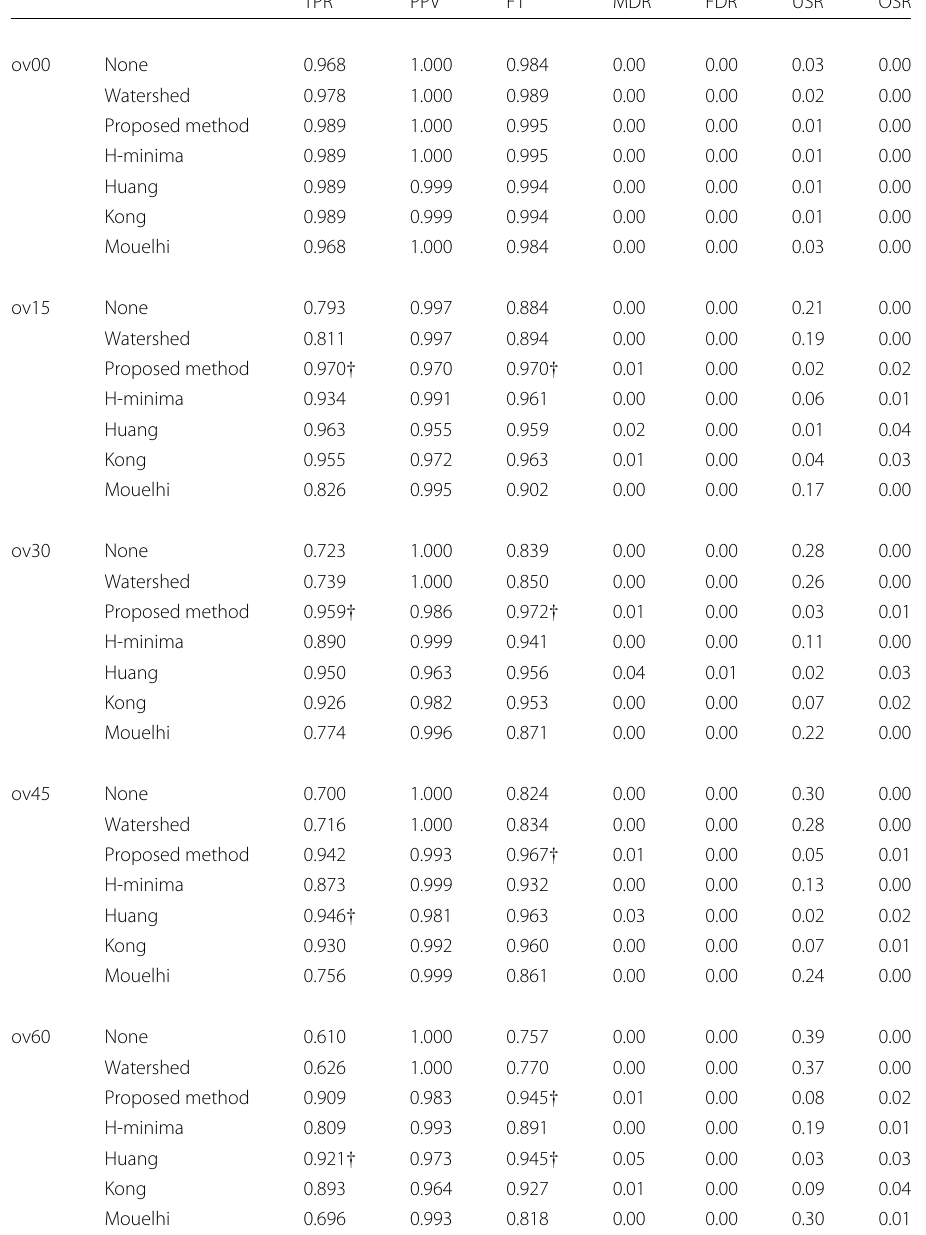
Table 2 Comparison of performance of cluster splitting methods on BBBC0004 dataset (None—images without applied cluster splitting method) TPR PPV F1 MDR FDR USR OSR ov00 None 0.968 1.000 0.984 0.00 0.00 0.00 0.978